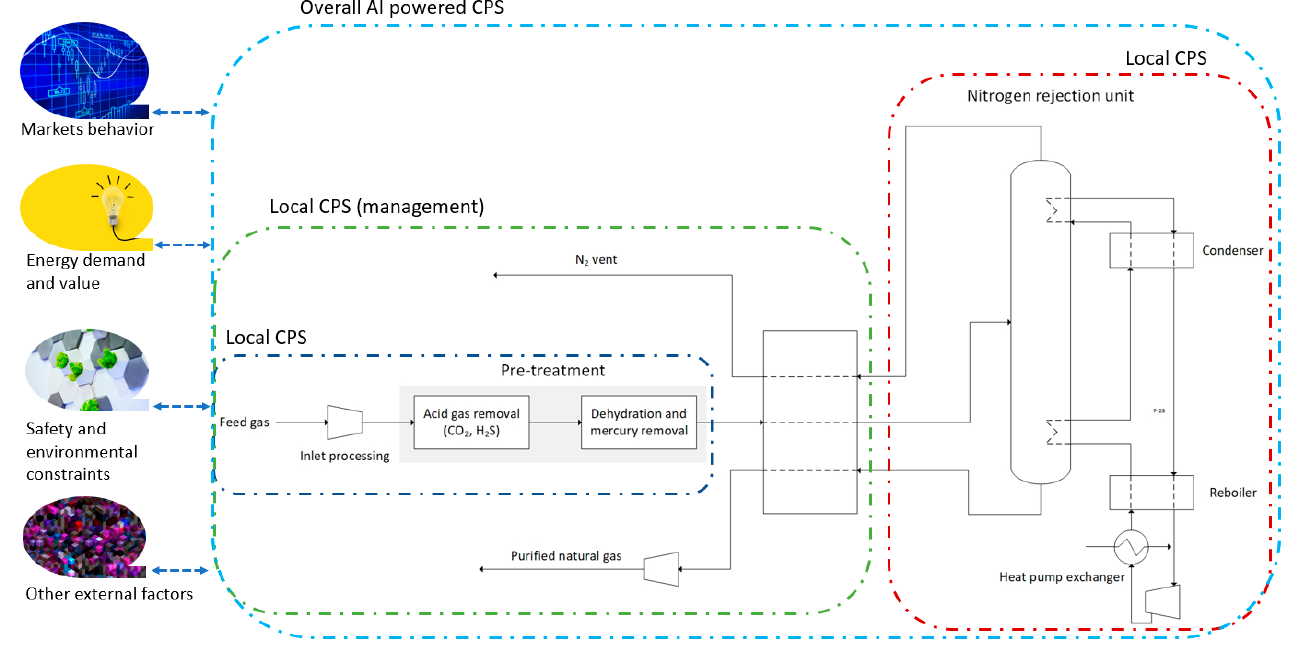
Figure 5. Process flowsheet of a single-column nitrogen rejection unit with a schematic representation of the possible locals CPS of this process and the overall CPS powered by AI with its connection to the external environment.